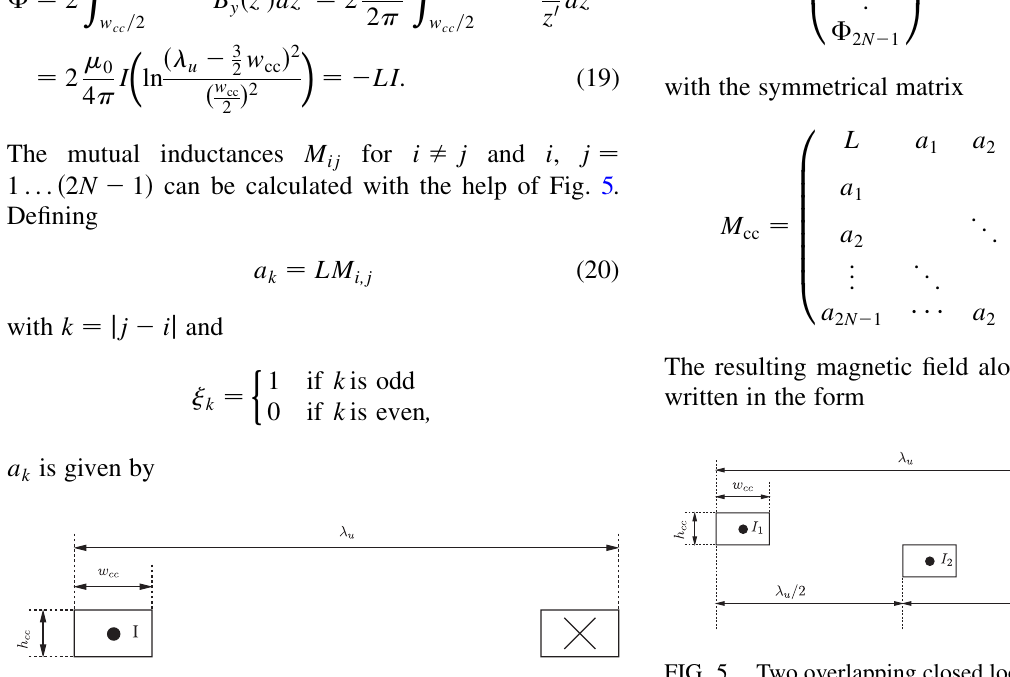
FIG. 4. One closed loop made out of two long straight wires.